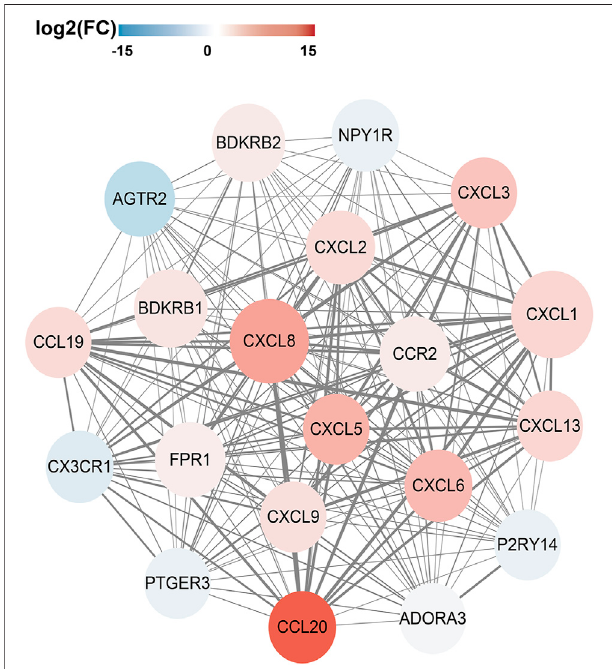
FIGURE 3 | PPI network and Hub genes selection. The Protein-Protein interaction network of DEGs was constructed by Cytoscape. The red nodes represent up-regulated genes, while the blue represent down-regulated genes. The color of node varies from fold change of DEGs. Size of the node is displayed upon degree of connectivity of the node. The width of the edge represents the value of combined score from 0.9 to 1.0. The signi fi cant clustersidenti fi ed from PPI network byMCODE plugin with the MCODE score > 5 and number of nodes > 10. The Cluster one consists of 20 nodes and 190 edges (score: 20.000).